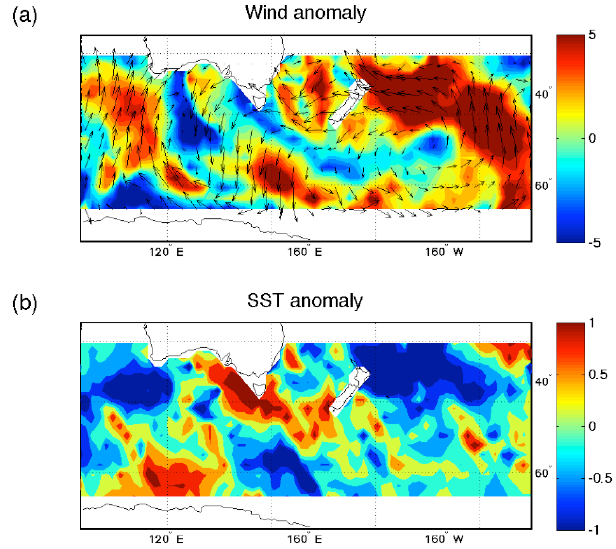
Figure 1. Anomalies of atmospheric (SLW) and oceanic (SST) fields on 1 December 2002, computed as the deviations from the average over the 16-day period of 1–16 December 2002: (a) sea-level wind (SLW) anomaly; (b) sea-surface temperature (SST) anomalies. The two fields are spatially correlated, over the region shown, with the correlation coefficient of –0.73.